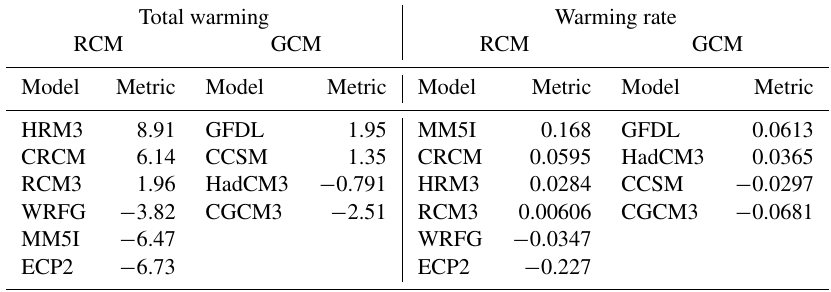
Table 5. Relative overall ordering of model contribution to different components of the warming signal, ordered from highest (top of table) to lowest (bottom of table). The metric used for ordering the models is the integrated estimated parameter value of the pointwise confidence regions. The units for the total warming metric are ◦ C × km 2 × 10 6 and the units for the warming rate metric are ◦ C × km 2 × 10 6 year − 1 .